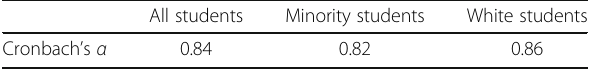
Table 13 Reliability statistics for MSLQ subsection on self- efficacy for learning and performance motivation All students Minority students White